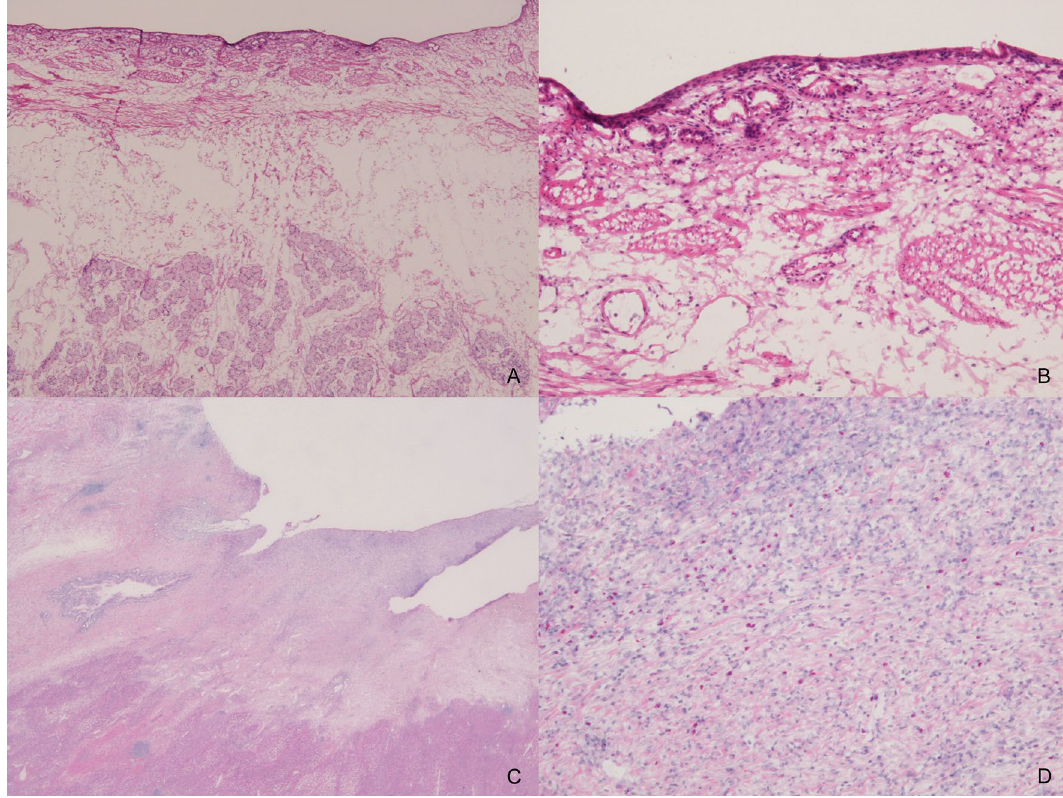
Figure 6. Photomicrographs of the histological sections of the bile duct after balloon-based radiofrequency ablation. The bile duct wall is thermally injured, and coagulative necrosis is observed at the bile duct wall and the surrounding tissue in specimens obtained on the same day as the procedure; tissues and cells affected by the ablation transform to a dry, dull eosinophilic area (( A ) × 40 magnification; ( B ) × 200 magnification). The site to be ablated has replaced the granulation tissue and fibrotic changes in the specimens 35 days after the ablation; tissues affected by the ablation comprise proliferated myofibroblasts and collagen fibers (( C ) × 20 magnification; ( D ) × 200